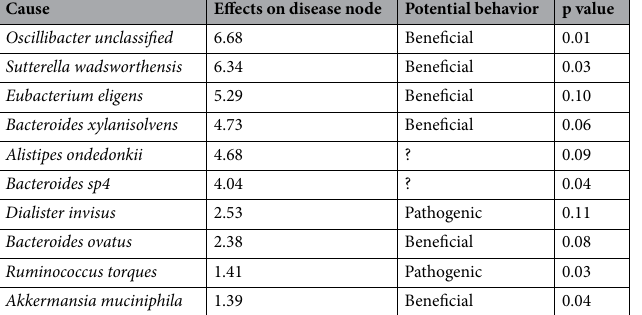
Table 3. Sorted list of taxa (descending order) based on causal effects on ulcerative colitis “disease” node. The p-value for each pairwise causal effect is also provided.